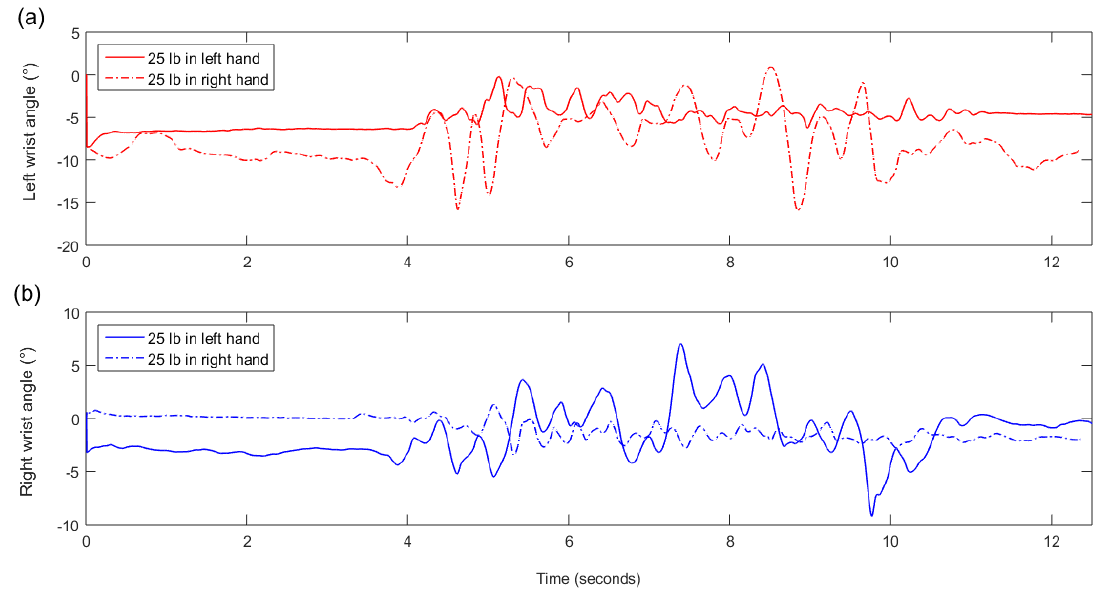
Figure 3. An example of one participant’s left ( a ) and right ( b ) wrist pronation / supination angle during asymmetric (unilateral) dumbbell carrying. The full line shows the angle for a trial where the participant carried a 25-lb dumbbell in their left hand while the dotted line shows the angle for a trial with a 25-lb dumbbell in their right hand. A common, though subjectively observed, pattern was that there is less wrist angle variability when a hand is holding a dumbbell—the variability in the left wrist angle ( a ) is lower when the dumbbell is held in the left hand, and the variability in the right wrist angle ( b ) is lower when the dumbbell is held in the right hand. Table 1. Number of selected features and classification accuracies for all five classification problems using three input data types: only inertial, only electromyography (EMG), or inertial + EMG. In each field, the first value is the number of selected features while the second is classification accuracy. Results are given for the support vector machine-based classifier in case of EMG data alone and for the regression-based classifier in the cases of inertial data alone and the combination of inertial and EMG data, as these classifiers exhibited the highest accuracies for those data